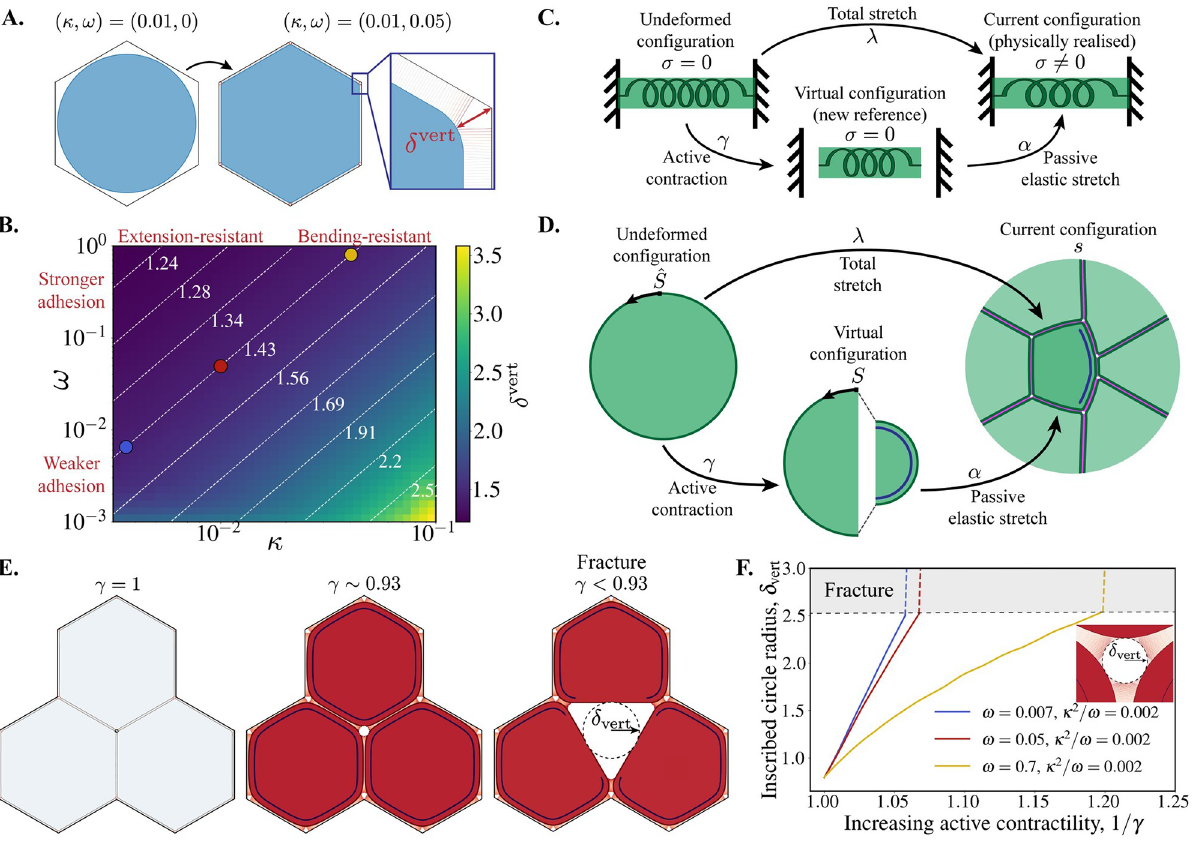
Fig 2. Relating cell geometry to the passive and active mechanical parameters in the ACAM. (A) A circular cell cortex is initialised with no adhesions ( ω = 0). The adhesion strength is quasi-statically increased to pull the cell towards the hexagonal boundary and close the vertices. (B) Map of parameter space showing the opening at a vertex, δ vert , (see A ) relative to the parameters κ and ω on a log scale. For each ( κ , ω ), the cell is recurrently relaxed to equilibrium with their rest lengths updated to the current length at every step, repeated until the cortex length change is less than 1 × 10 − 4 . Dashed white lines show isolines of fixed δ vert , corresponding to constant κ 2 / ω . Coloured circles show the parameter samples along the isoline used in F . (C) The three configurations of a morphoelastic spring. An active contraction would take the spring from its undeformed configuration to a new theoretical reference (virtual) configuration, where the spring is stress free. An elastic stretch, imposed by the boundary conditions, brings the spring to its current (physically realised) configuration, with non-zero stress ( σ 6¼ 0). (D) A cell cortex in the morphoelastic framework: the undeformed configuration (parameterised by ^ S ) is taken to the virtual/reference configuration (parameterised by S ) by an active pre-stress e.g. from Myosin contraction ( γ < 1 locally, marked by dark blue line). Forces from boundary conditions and external body loads then bring the cortex to the physically realised configuration, called the current configuration (parameterised by s ), with an elastic stretch, α . The total stretch, λ , at a location on the cortex is the product of active contraction and external pulling: λ = γα . (E) Snapshots from a 3-cell simulation with ( κ , ω ) = (0.01, 0.05) and increasing active cortical contractility in all cells ( γ decreasing from 1; see also S1 Movie). The tissue fractures when γ < 0.93. The dashed line shows a circle inscribed within the vertex, with radius δ vert . (F) Radius of the vertex-inscribed circle vs. the inverse magnitude of active contractility for three parameter samples on the κ 2 / ω = 0.002 isoline in passive parameter space, where δ vert is constant (coloured dots in B ).